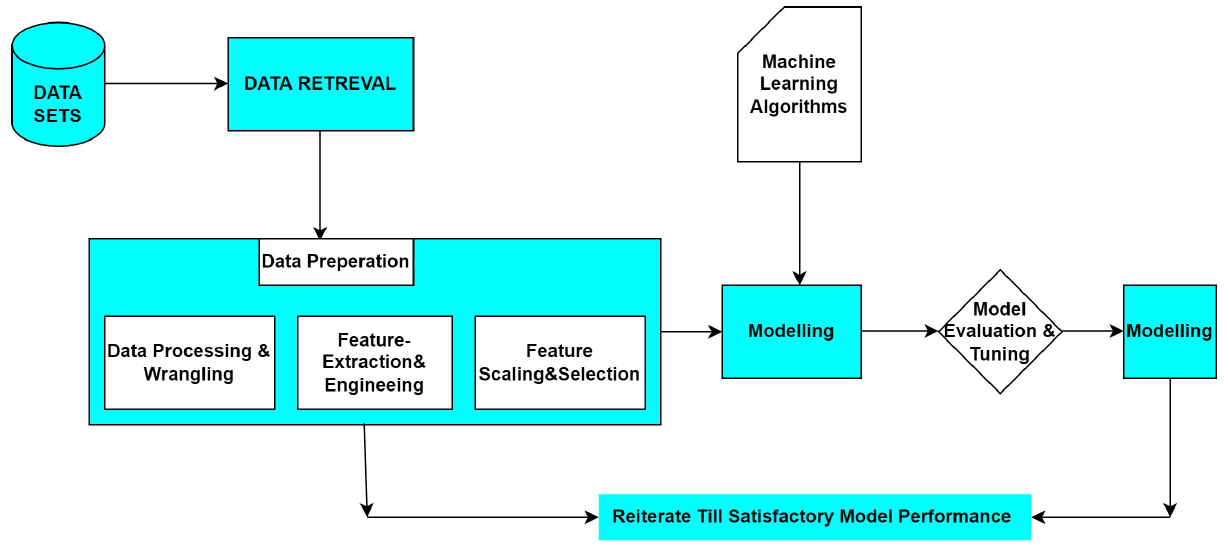
Figure 1. Architecture of the